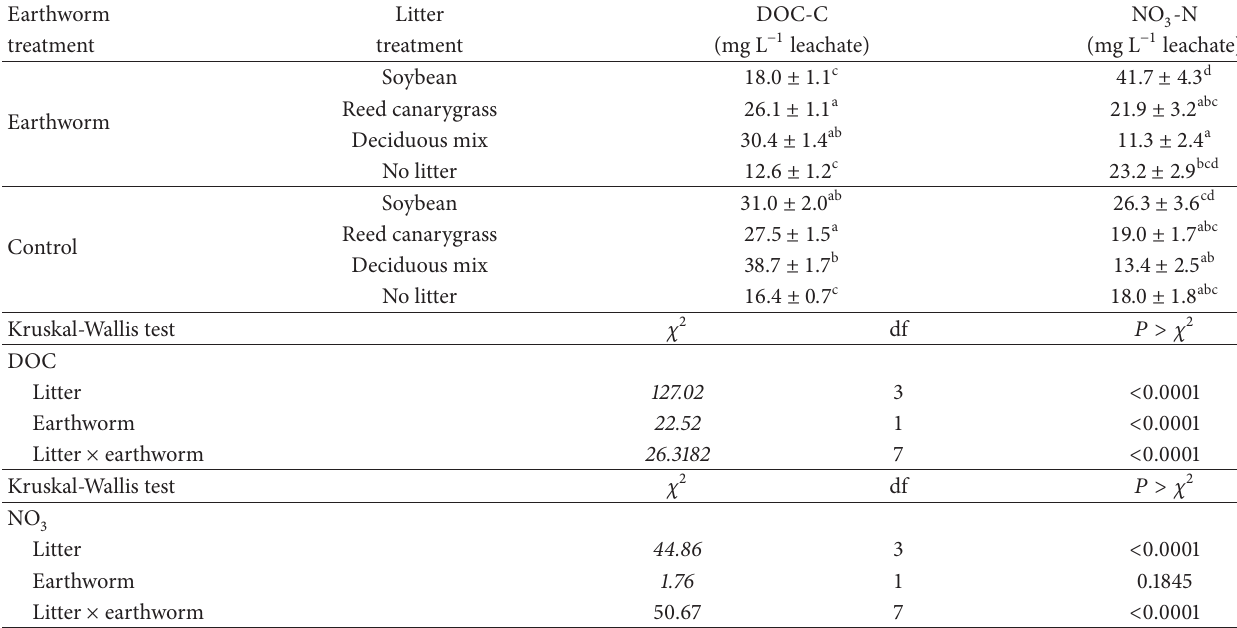
Table 3: Dissolved organic carbon (DOC) and nitrate (NO 3 ) from microcosms containing riparian soils. Values are the mean ( ± standard error) of nine sampling dates ( 𝑛 = 144 ). Within a column, values followed by the same letter are not significantly different ( 𝑃 < .05 ) according to Dunn-Nemenyi’s procedure for multiple comparisons.